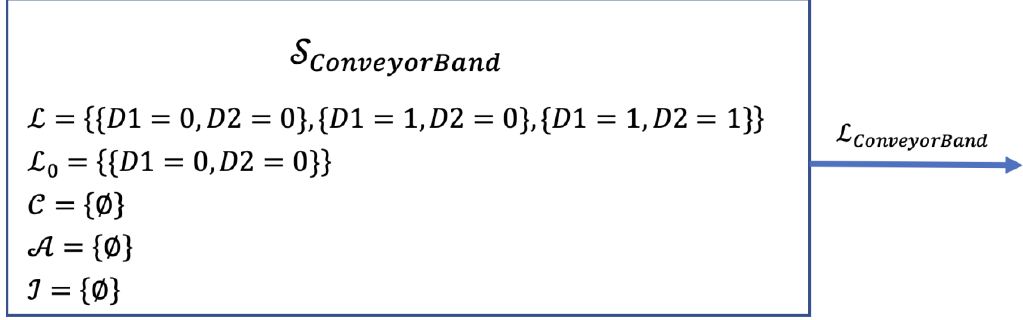
Figure 13. Block diagram of the product detector module.